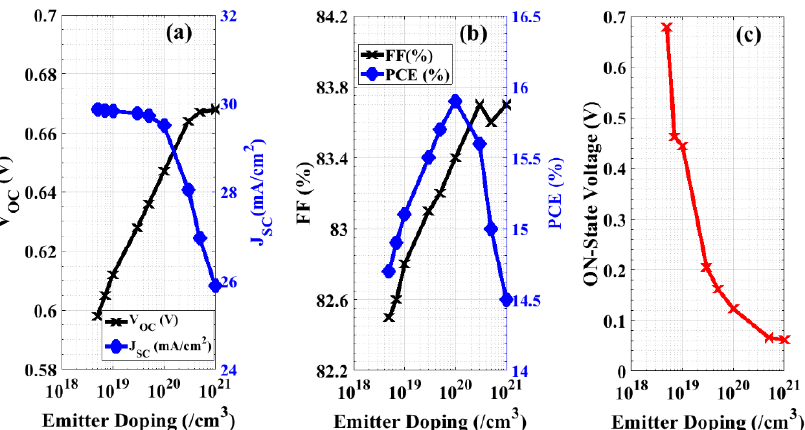
Figure 8. Performance of the novel cell by optimizing the doping concentration of the emitter. ( a ) Open-circuit-voltage and short-circuit current density, ( b ) fill factor and power conversion effi- ciency, and ( c ) ON-State voltage.